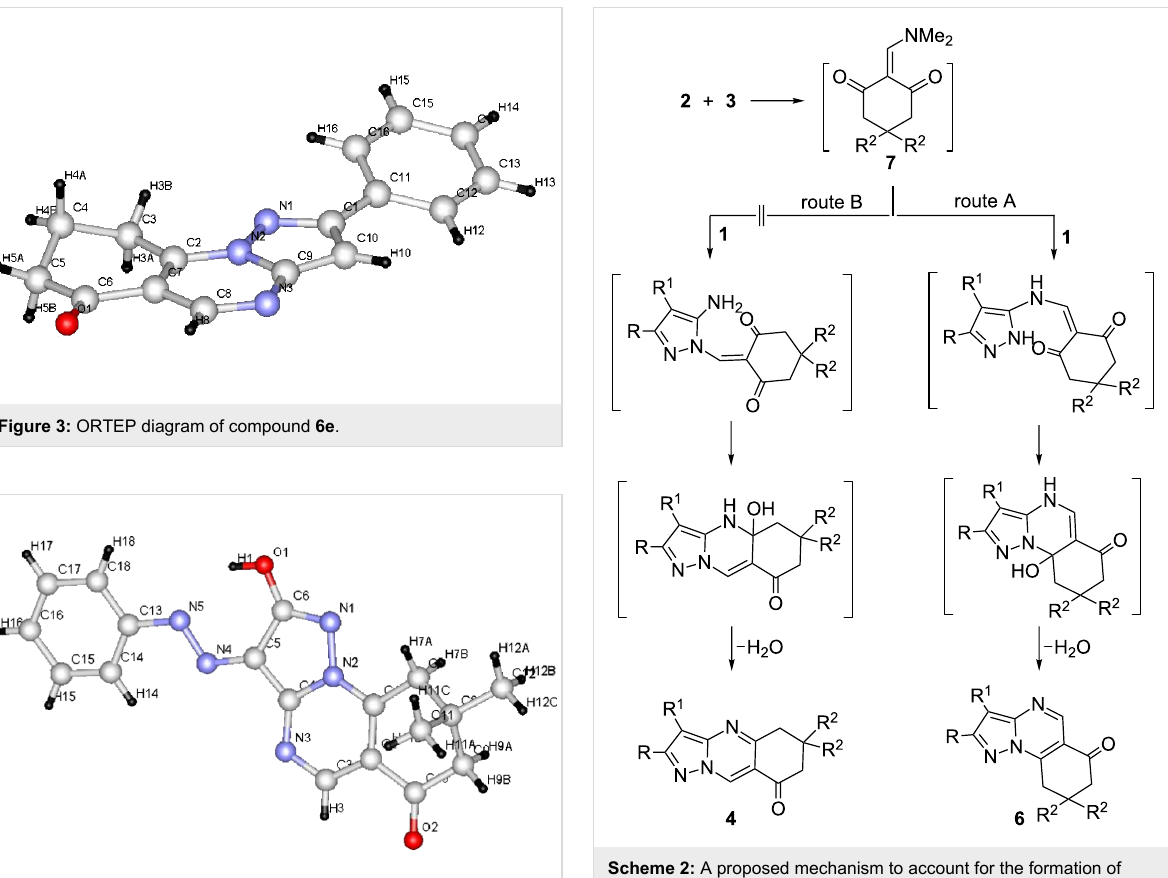
Figure 4: ORTEP diagram of compound 6g .